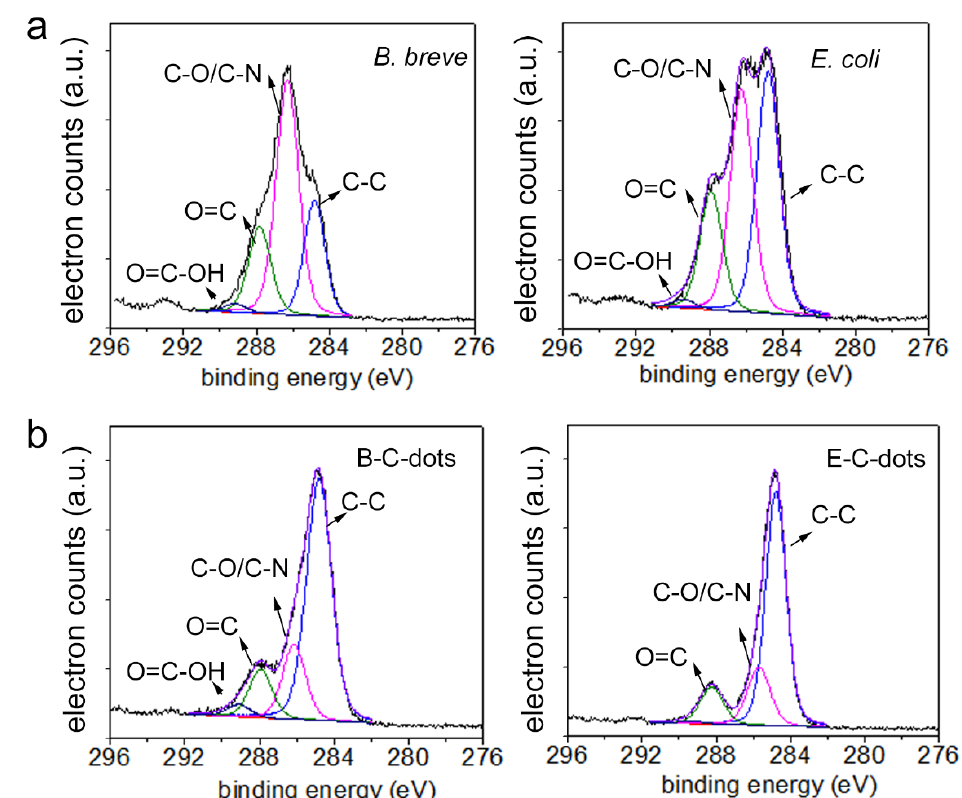
Figure 2. Narrow-scan C 1s binding energy spectra. ( a ) Spectra of B. breve ATCC 15700 and E. coli ATCC 25922 as carbon sources. ( b ) Spectra of B-C- and E-C-dots, as derived from the carbonization of B. breve and E. coli , respectively.